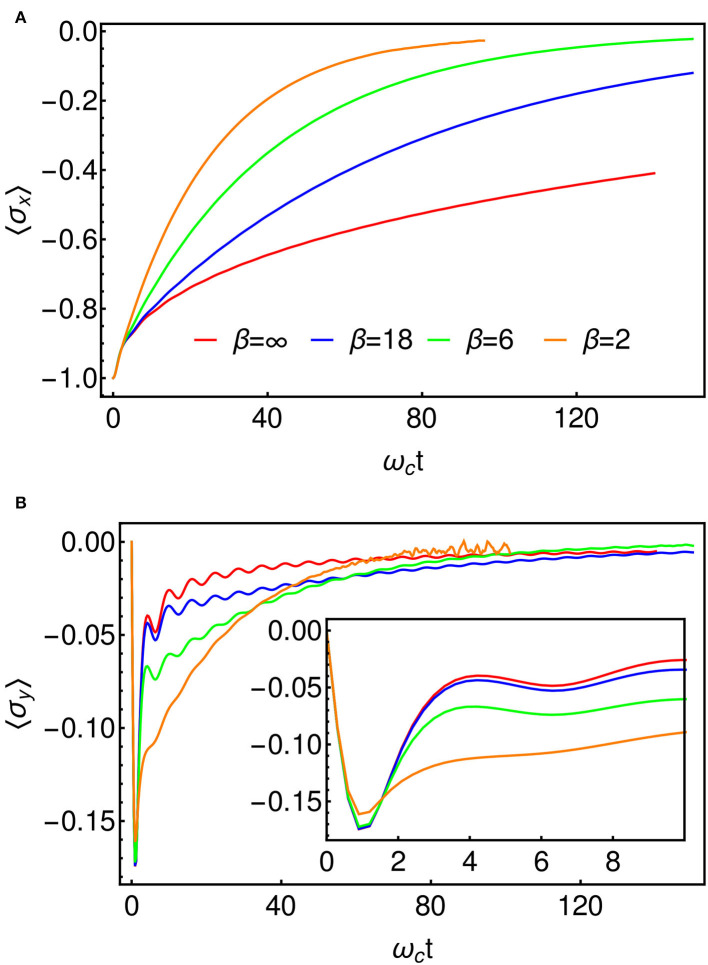
(A) 〈σx(t)〉 for several temperatures, which represents the progress of the reaction. The decay to the steady state is exponential at high temperature. (B) 〈σy(t)〉, representing the momentum along the reaction coordinate. We encounter some noise beyond about ωct = 50 in the β = 2 data. This is as a result of the truncation of the local Hilbert spaces of the bath modes (cf. section 3). The inset shows an enlarged view of the initial fast dynamics which appear to be broadly independent of temperature.